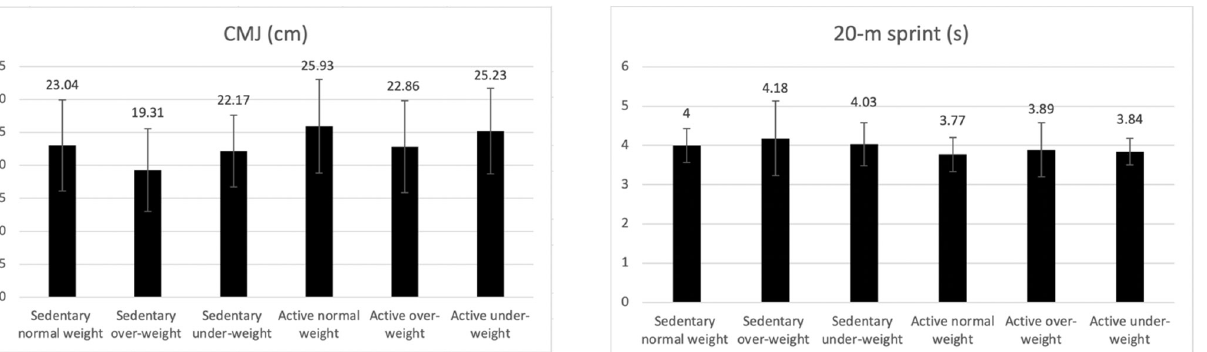
Figure 3. Descriptive values of anthropometric, nutritional, and physical fitness variables of active and sedentary adolescents according to their BMI.